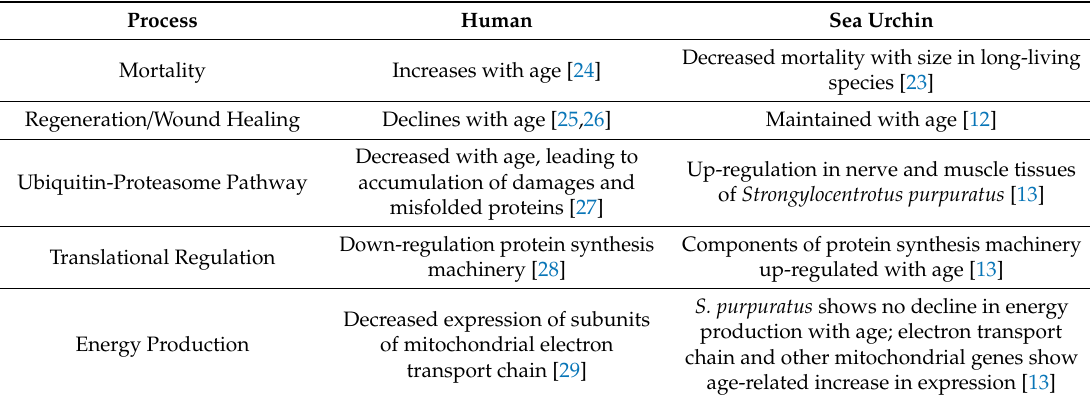
Table 1. A comparison of age-related processes reported in sea urchins compared to similar processes in